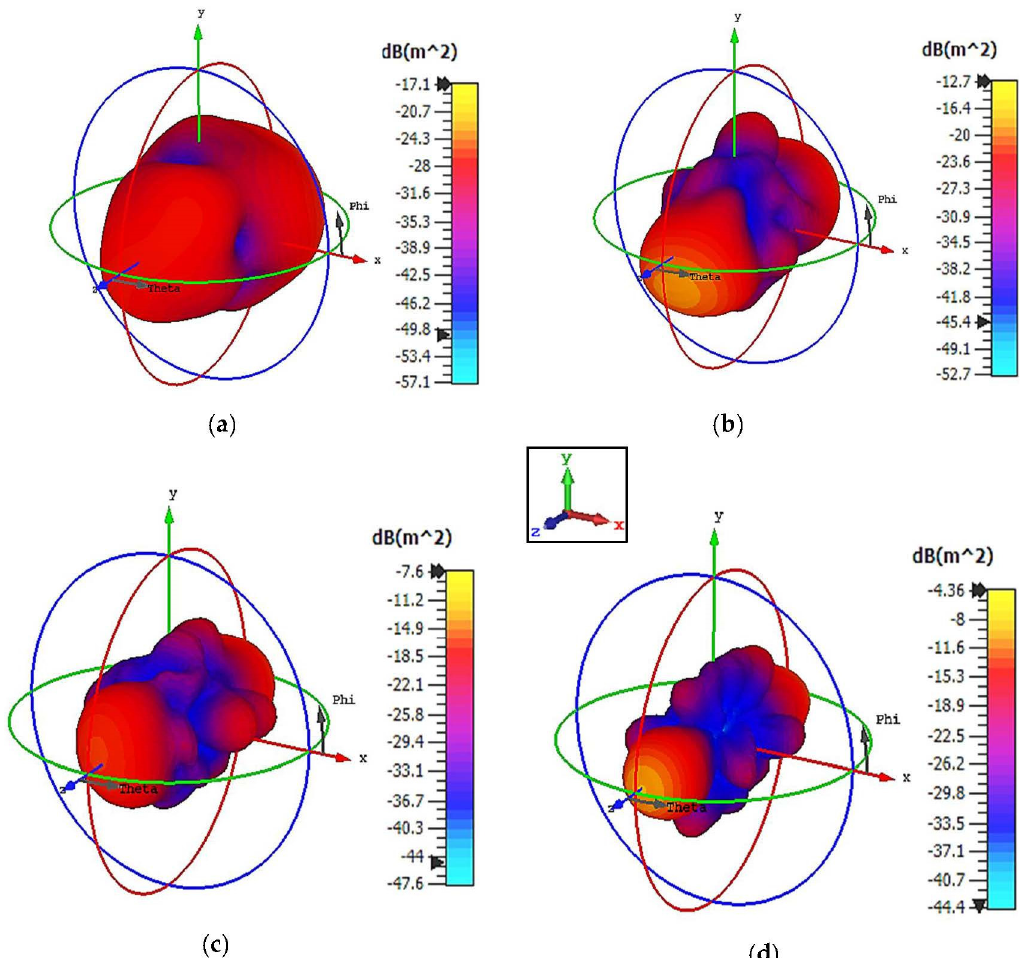
Figure 15. Bistatic scattering patterns at 8 GHz for ( a ) 4 lattices; ( b ) 6 lattices; ( c ) 8 lattices; and ( d ) 12 lattices.